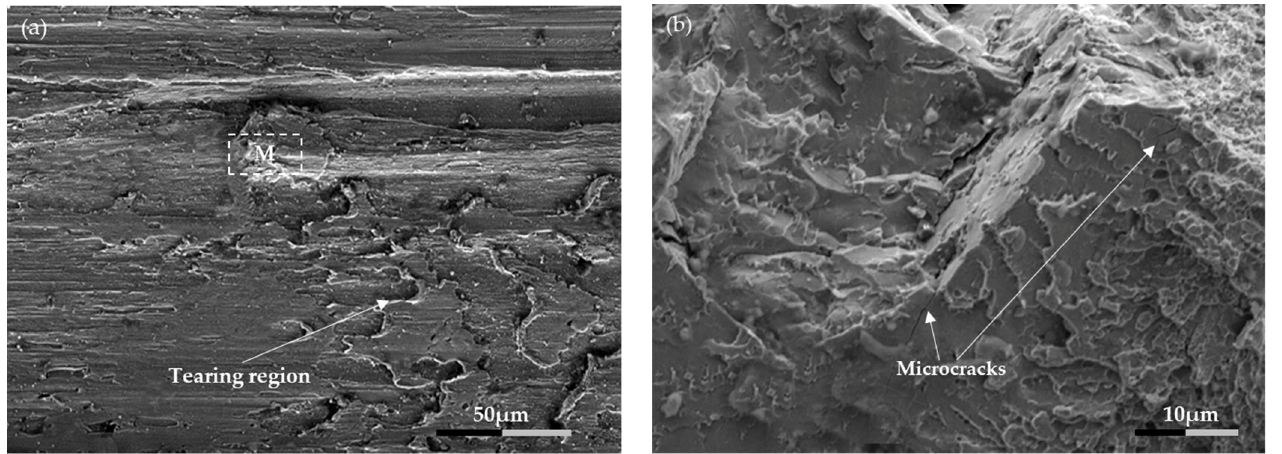
Figure 11. SEM image of fracture interface in fracture mode I: ( a ) Fracture surface on Ti 2 AlNb side; ( b ) High magnification image of M.